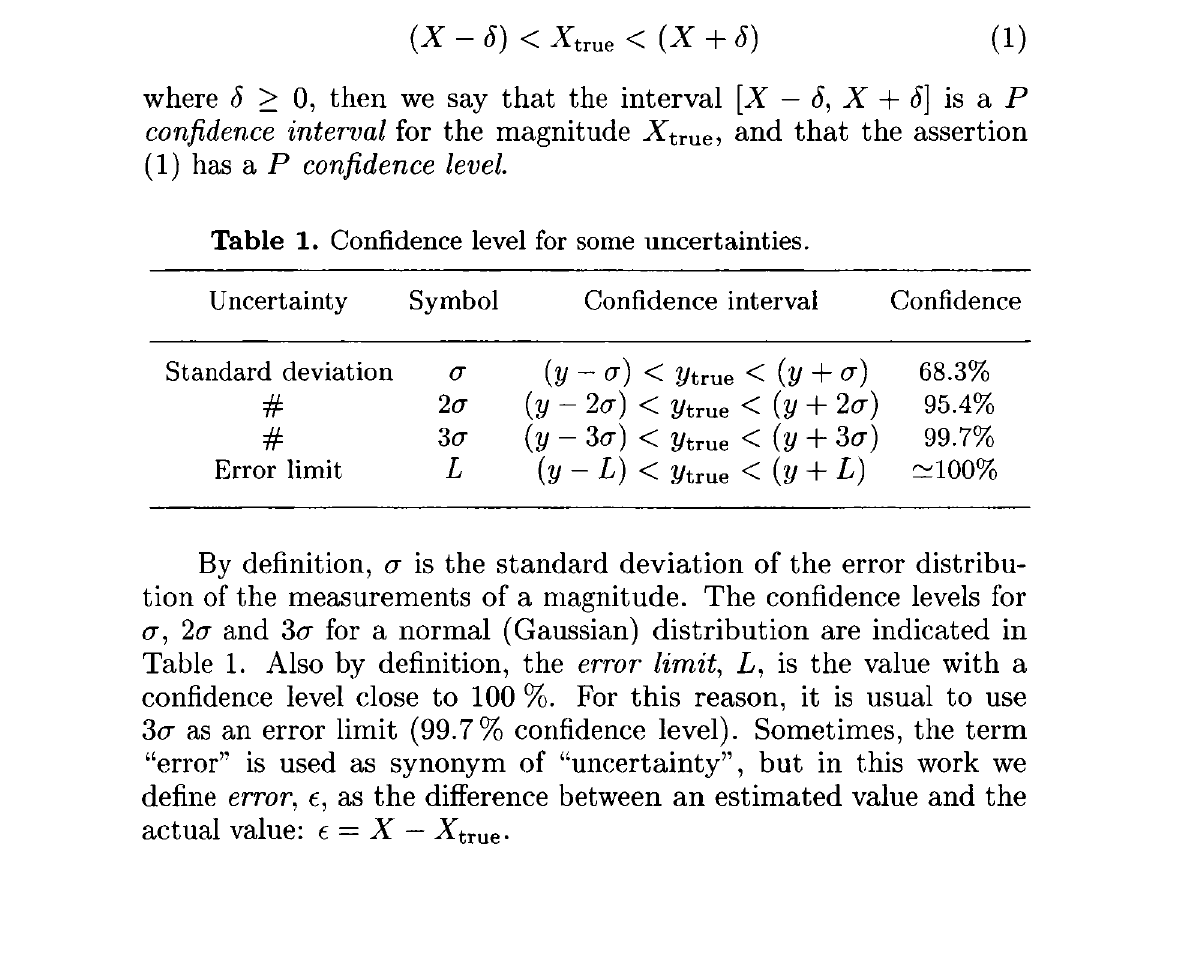
Table 1. Confidence level for some